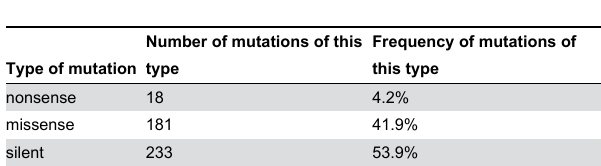
Table 4. Predicted effect of mutations on gene product.